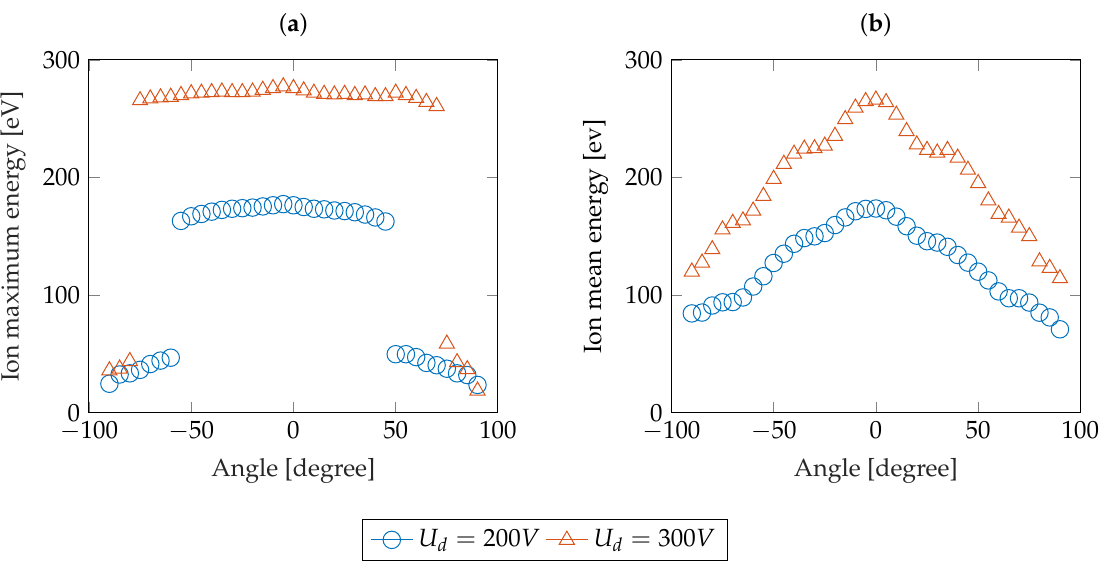
Figure 12. Angular distribution of the ion most probable energy ( a ) and mean energy ( b ), at 200 V and 300 V with 5 sccm mass flow rate.